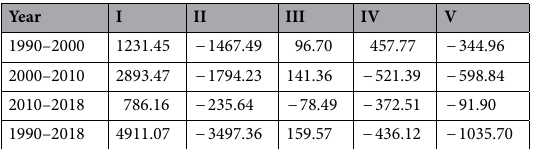
Table 4. Changes in habitat quality level measured by area (km 2 ).